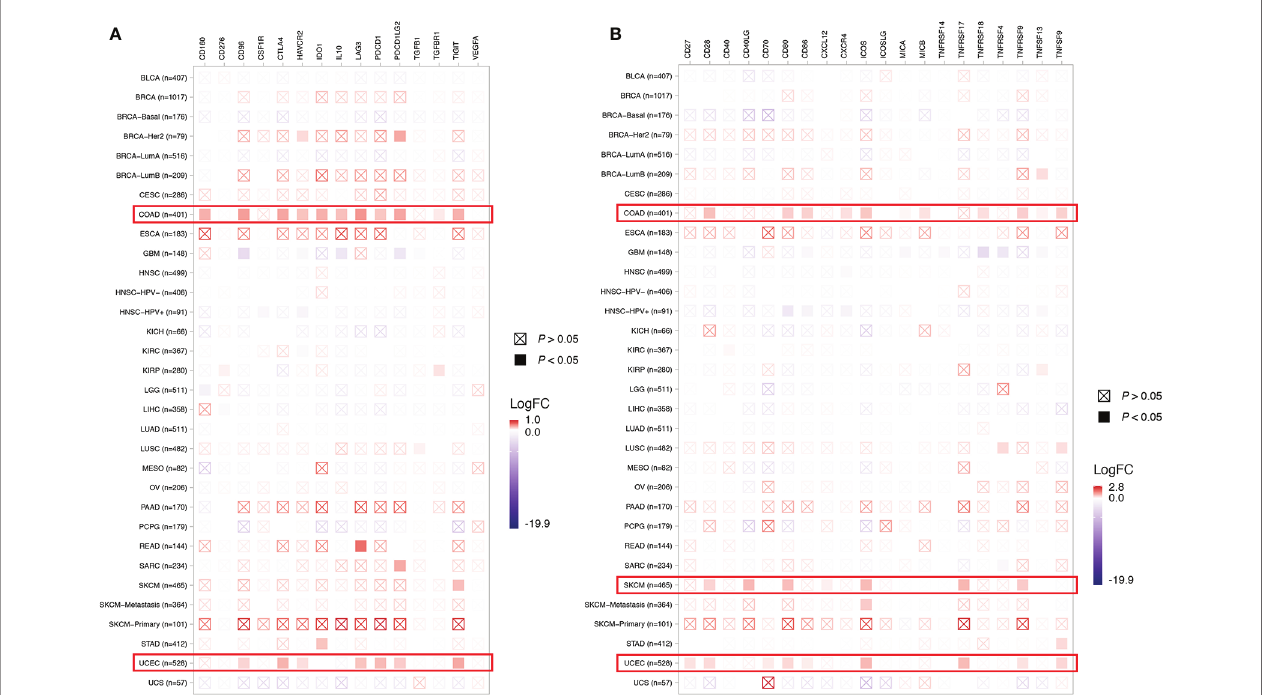
FIGURE 6 | Association between KDM5C alterations and several inhibitory (A) and stimulatory (B) immune checkpoints expression across different cancer types. BLCA, Bladder Urothelial Carcinoma; BRCA, Breast invasive carcinoma; CESC, Cervical squamous-cell carcinoma and endocervical adenocarcinoma; COAD, Colon adenocarcinoma; ESCA, esophageal carcinoma; GBM, Glioblastoma multiforme; HNSC, head and neck squamous cell carcinoma; KICH, kidney chromophobe; KIRC, kidney renal clear cell carcinoma; KIRP, kidney renal papillary cell carcinoma; LIHC, Liver hepatocellular carcinoma; LUAD, lung adenocarcinoma; LUSC, lung squamous-cell carcinoma; MESO, mesothelioma; OV, ovarian serous cystadenocarcinoma; PAAD, pancreatic adenocarcinoma; PCPG, pheochromocytoma and paraganglioma; READ, rectum adenocarcinoma; SKCM, Skin cutaneous melanoma; STAD, Stomach adenocarcinoma; UCEC, Uterine corpus endometrial carcinoma; UCS, uterine